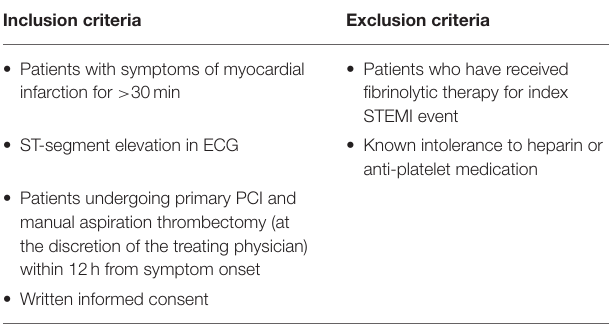
TABLE 1 | Eligibility criteria for the QUEST STEMI